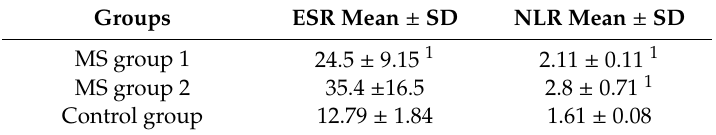
Table 2. Biological markers of inflammation status in MS and healthy control